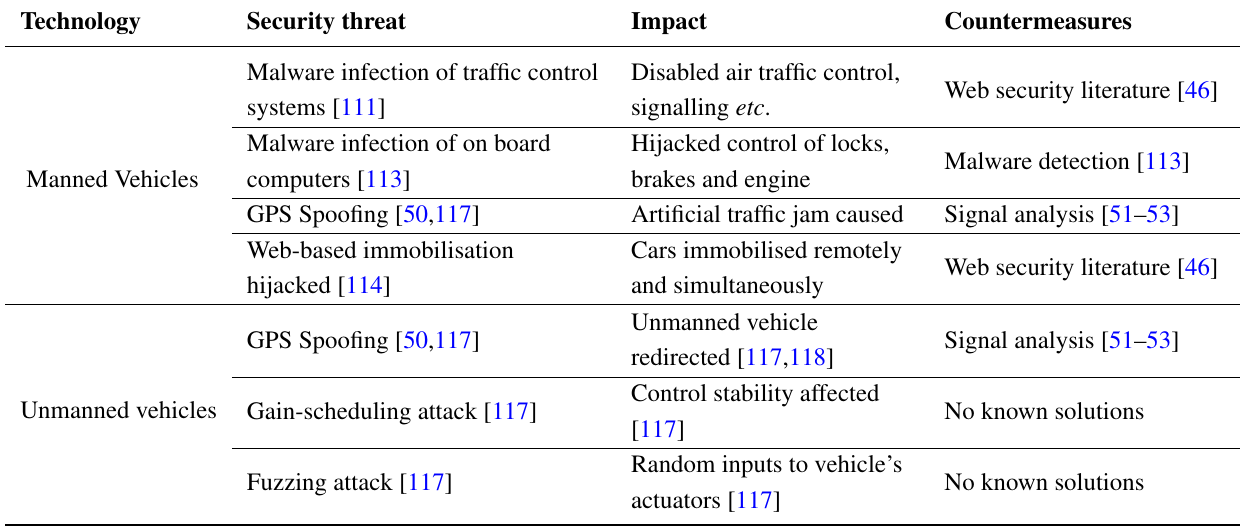
Table 4. Vehicular EM security threats and proposed